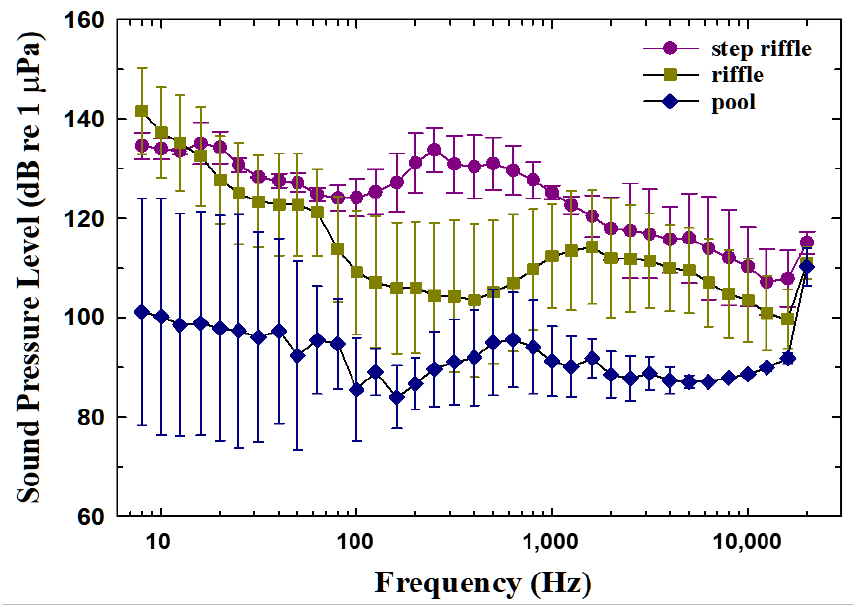
Figure 8. Sound pressure level versus ⅓ octave band frequency in three channel types. The error bars illustrate the standard deviation of the obtained average.